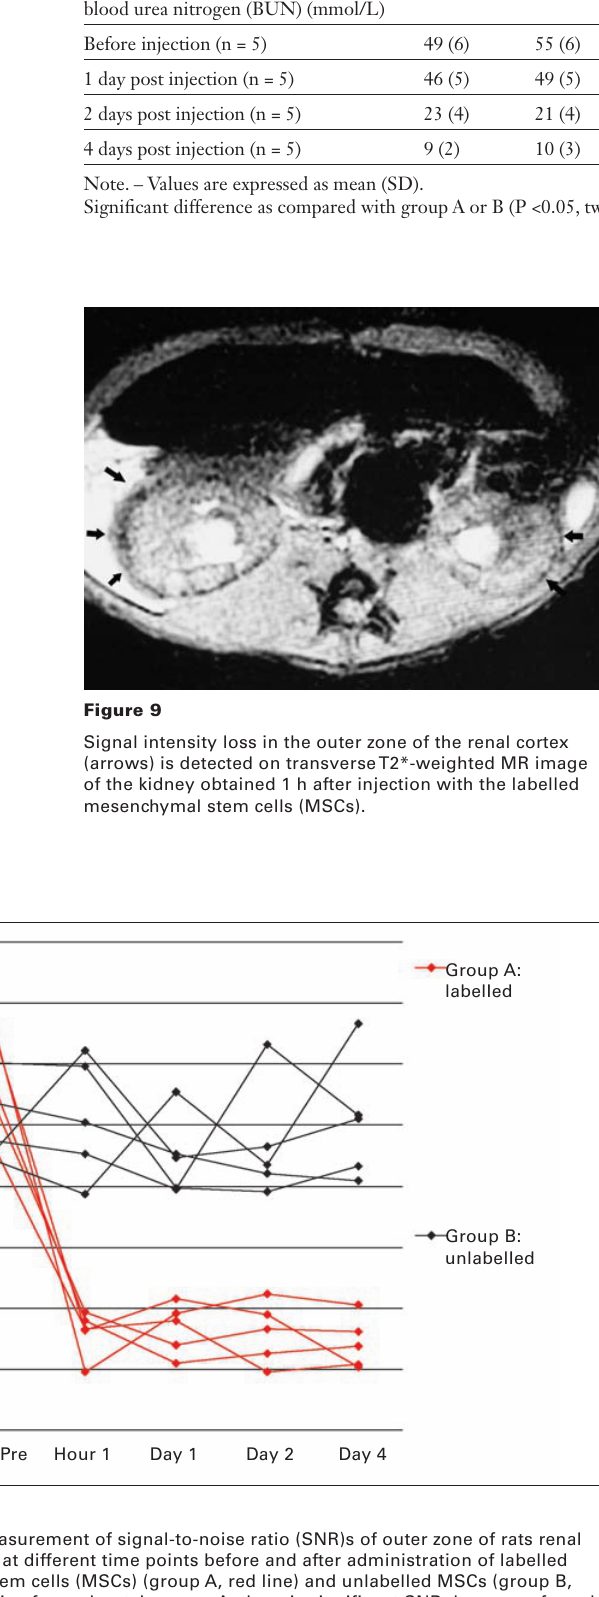
Renal function pa- rameters of the rats in 3 groups at differ- ent time points be- fore and after mes- enchymal stem cells (MSCs) or phosphate- buffered saline (PBS)